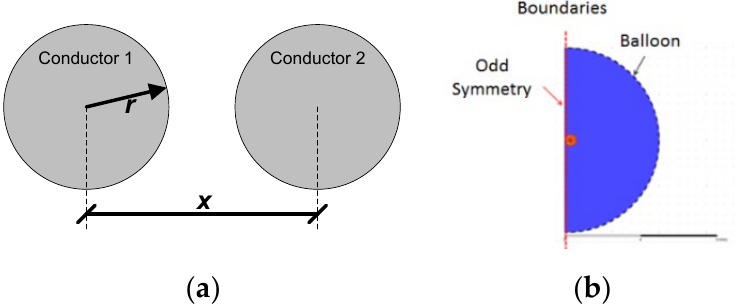
Figure 3. ( a ) Representation of two neighbor conductors; ( b ) axisymmetric FEA setup for the proximity effect evaluation between adjacent round conductors (symmetry axis at x/2 in an air analysis space of 15 mm of radius with vector potential A = 0 in the outer edge).